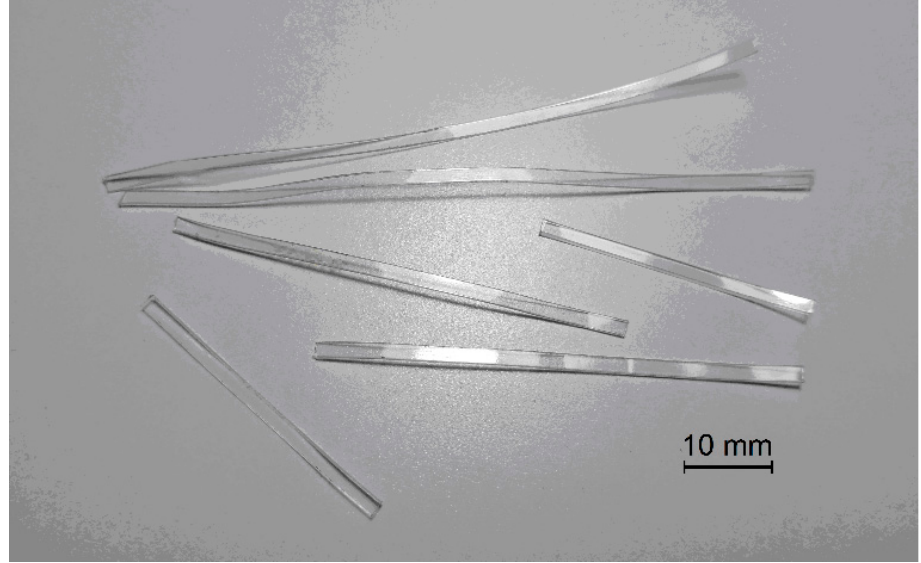
Figure 1. Single recycled PET fibres with a width of 2 mm and lengths of 38 mm; 62 mm; and 93 mm.